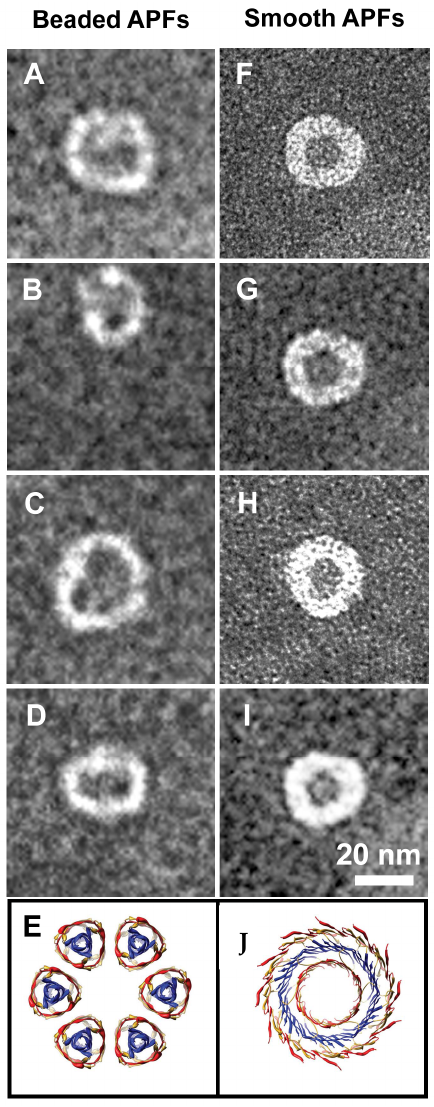
Figure 10. The two kinds of sCT-APFs observed outside liposomes: “beaded” ( A – D ) and “smooth” ( F – I ). For comparison, the molecular structures obtained by molecular dynamics simulation by Shafrir et al. for Aβ [43], are also shown ( E , J ).